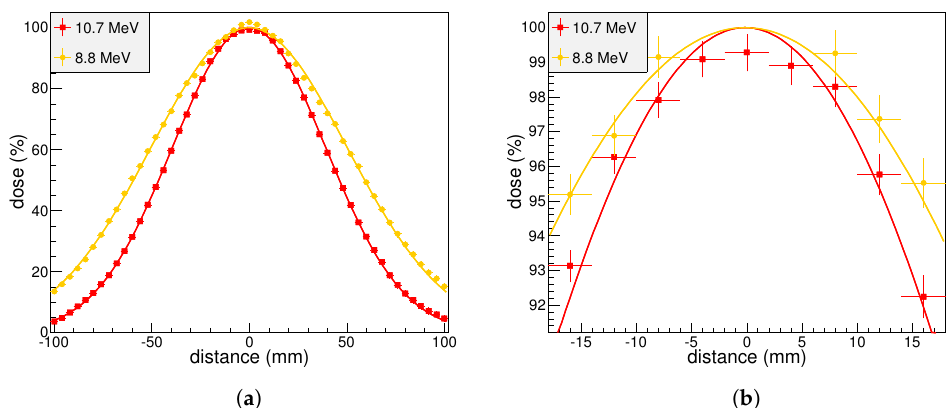
Figure 9. ( a ) comparison of full dose profiles obtained with a 150 µ m thick tungsten foil (red squares), corresponding to a mean energy of 10.7MeV at the film active volume, and with a 200 µ m thick foil (yellow dots), corresponding to a mean energy of 8.8MeV; ( b ) zoom of the same profiles in the region where samples are meant to be placed, after the PMMA circular collimator of 35 mm diameter. Deviations from the maximum dose of 8% and 5% are observed for the 10.7 MeV and 8.8MeV incident beams,